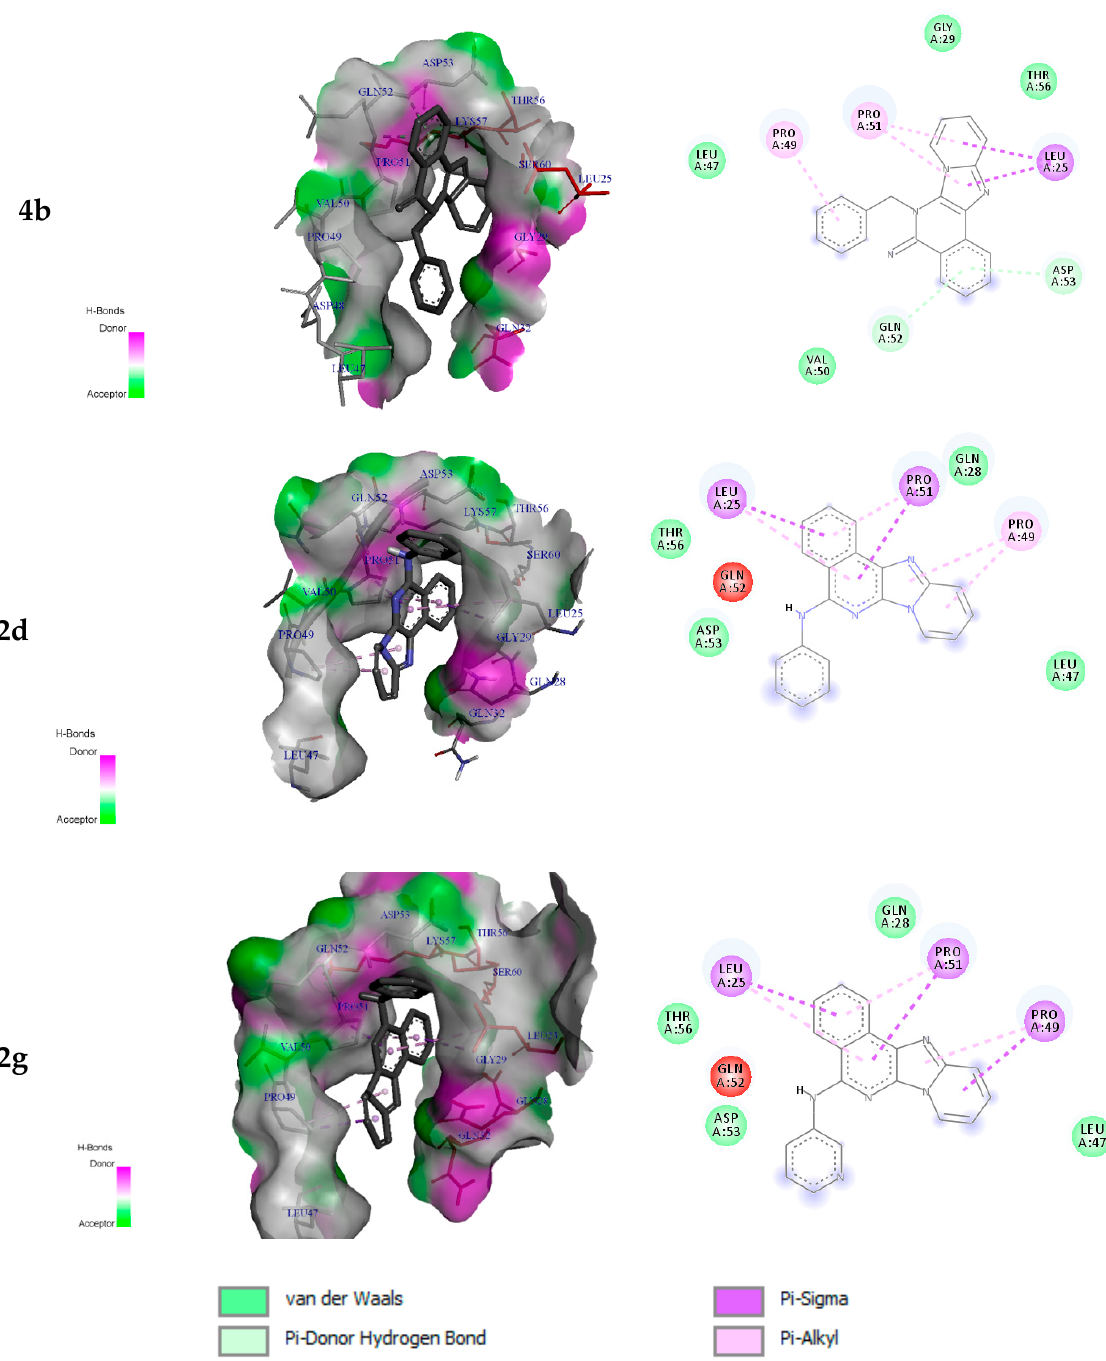
Figure 6. Hydrogen bond regions as exhibited by the active site ( left ). VDW and mixed/ π -alkyl hydrophobic interactions ( right ) as exhibited by compounds 2d , 2g and 4b .